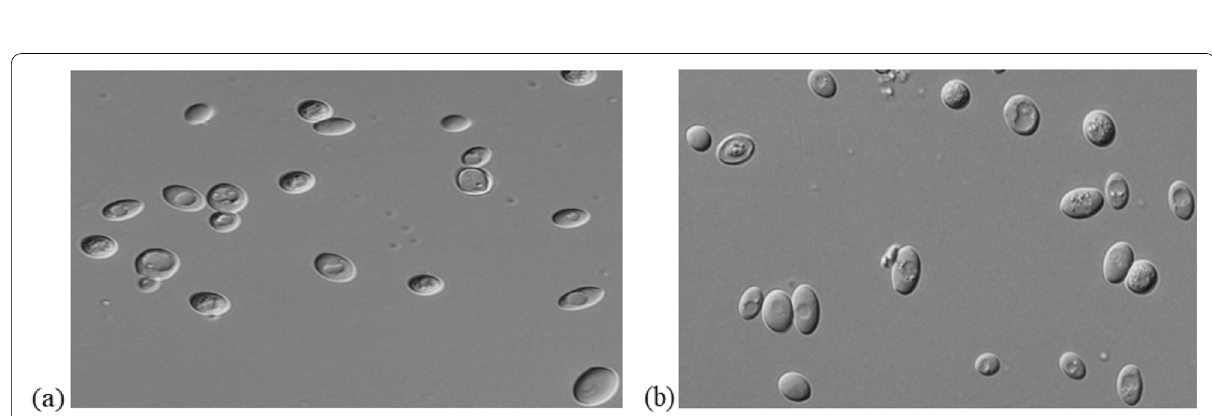
Fig. 2 The cellular morphology of M. caribbica isolate MJTm3 photographed at 100 exposed to pH 5.5 ( a ) and 3.2 ( b ) after